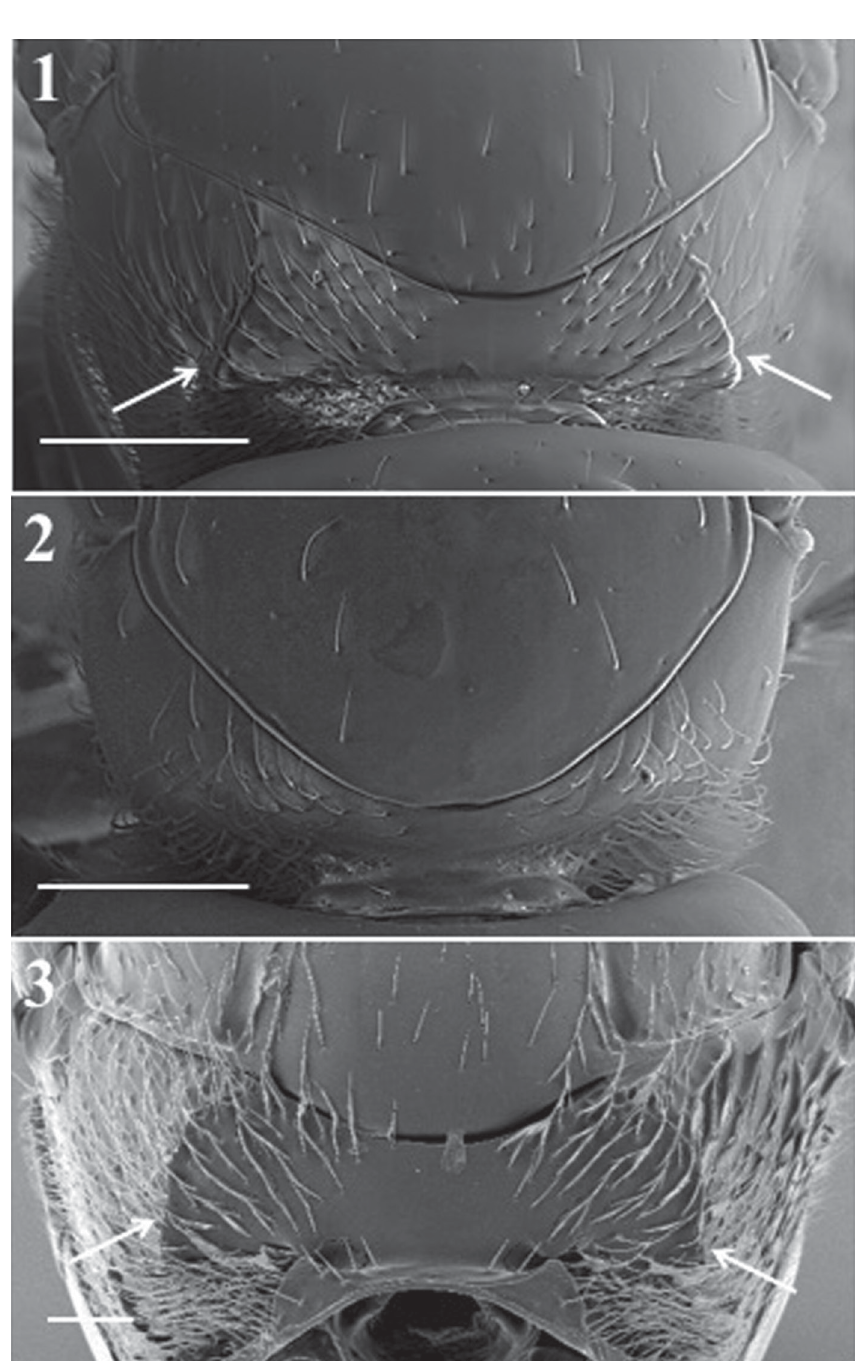
Fig. 8. Types of pronotum. 1 . Alloxysta arcuata (Kieffer, 1902). 2 . A. brevis (Thomson, 1862). 3 . Phaenoglyphis americana Baker, 1896. Scale bars: 50